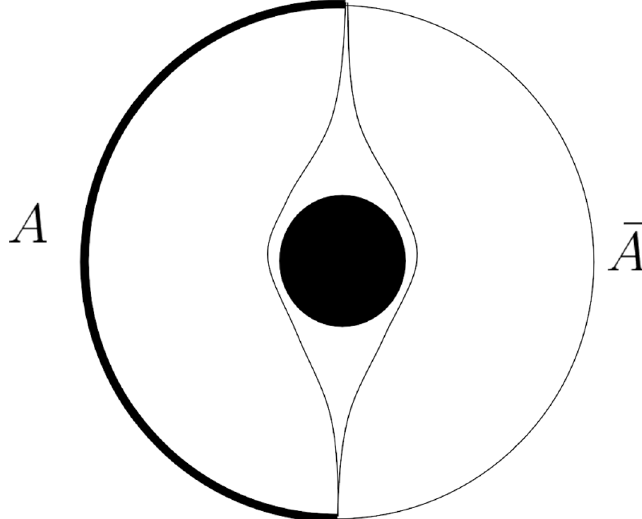
Figure 22 . A one-sided black hole forms a Python’s Lunch between one half of the boundary, region A , and the other half, region (cid:22) A . There is an extremal surface either side of the black hole, with the ‘bridge-to-nowhere’ of the black hole forming the bulging